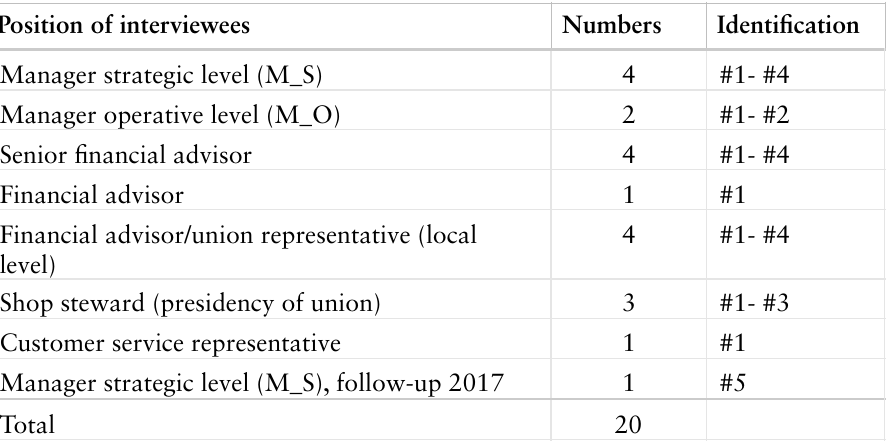
Table 1. Position, numbers and identi fi cation of